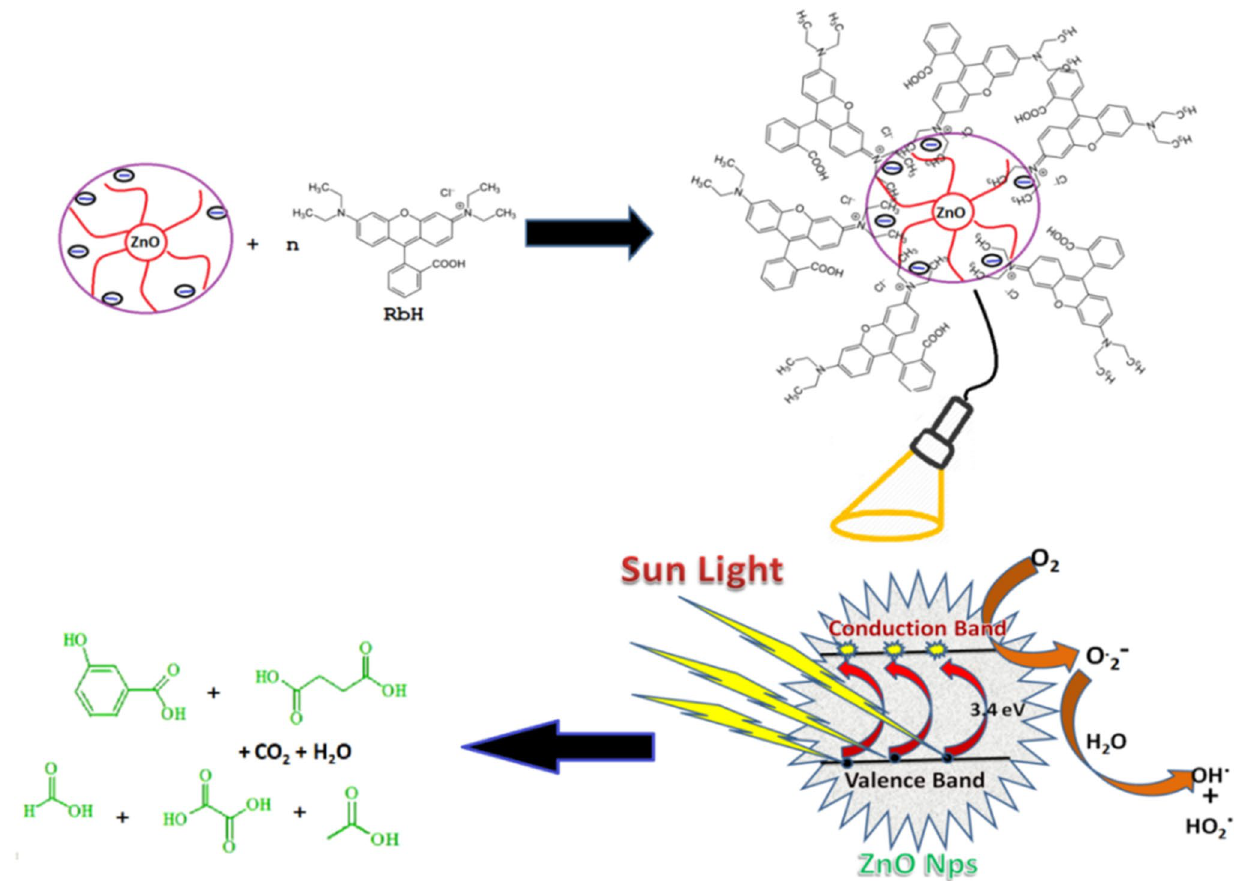
Fig. 14 Schematic mechanism for degradation of